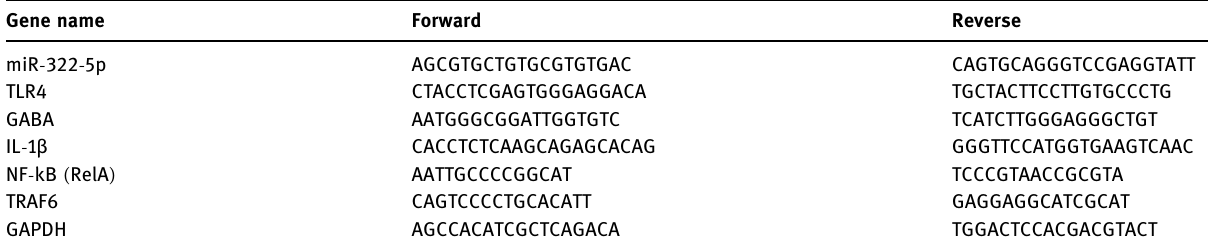
Table 1: Primer sequences for real - time